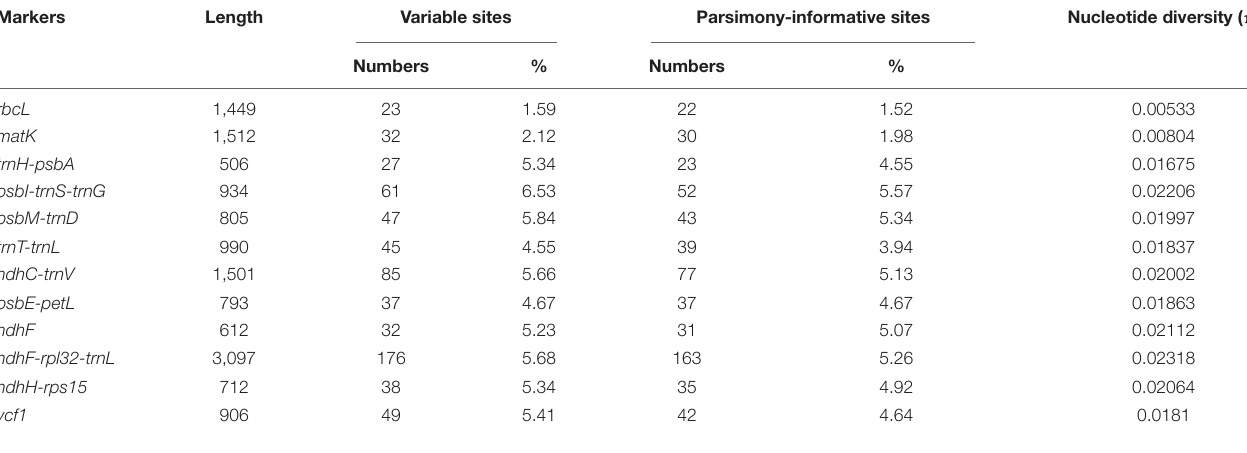
TABLE 3 | Nine hypervariable regions of chloroplast genomes of Phytolacca